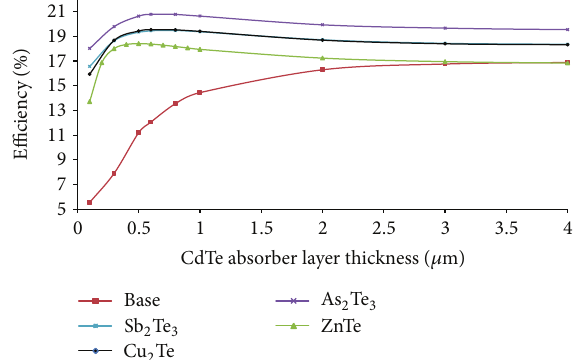
Figure 6: Effect of different BSF on cell overall efficiency on proposed cell with variable absorber